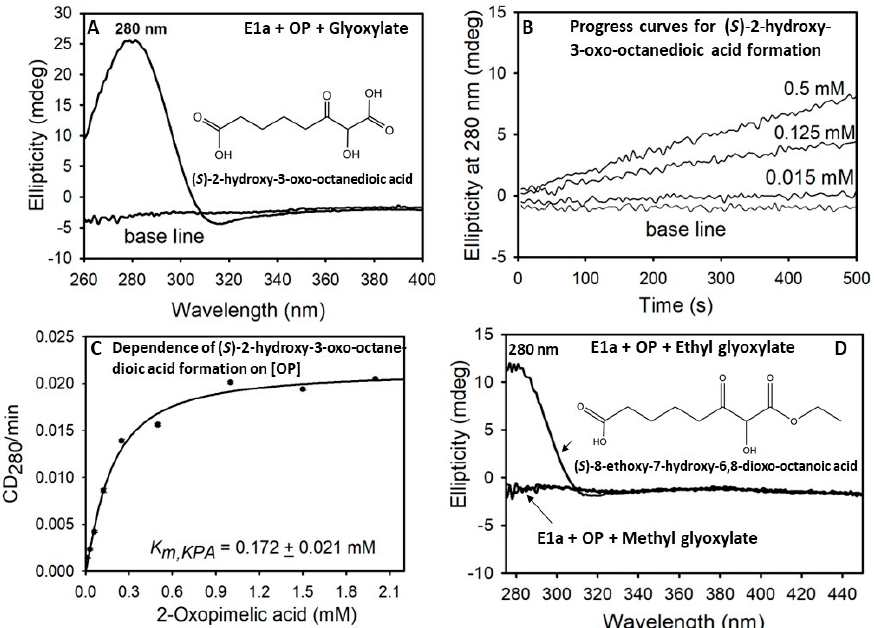
Figure 1. Formation of the carboligation products by E1a from OP. ( A ) CD spectrum of the ( S )-2- hydroxy-3-oxo-octanedioic acid product formed by E1a from OP and the glyoxylate as an acceptor. ( B ) Progress curves of the ( S )-2-hydroxy-3-oxo-octanedioic acid formation. ( C ) Dependence of the reaction rates on [OP]. Data points were fit to a modified Hill equation [CD 280 = yo + ((CD 280max × x n )/(S 0 . 5n + x n ))] and the line is the regression fit trace. ( D ) CD spectra of the carboligation products formed by E1a from OP and ethyl glyoxylate or methyl glyoxylate as acceptors. See Materials and Methods for experimental